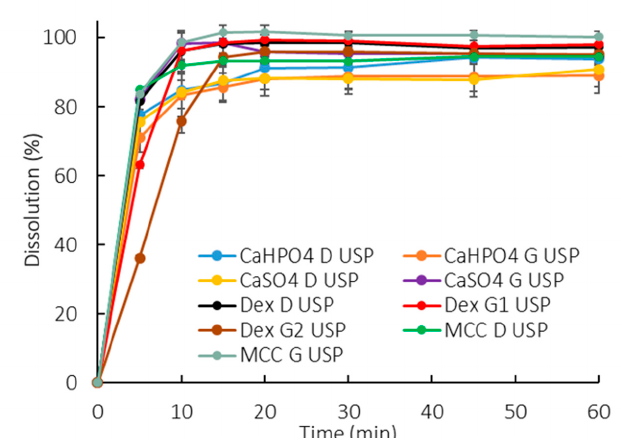
Figure 2. Dissolution profiles of all formulations in 900 mL of compendial buffer (50 mM phosphate buffer pH 7.2). Error bars represent the standard deviation.